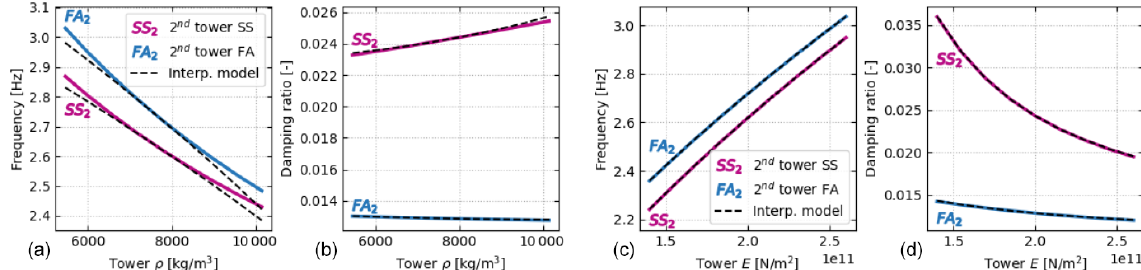
Figure 4. Variation of the second tower mode damped frequencies and damping ratios as a function of tower properties evaluated using the direct method (plain lines) and the interpolation method (dashed lines). (a, b) Variation of the tower density, ρ . (c, d) Variation of the tower Young